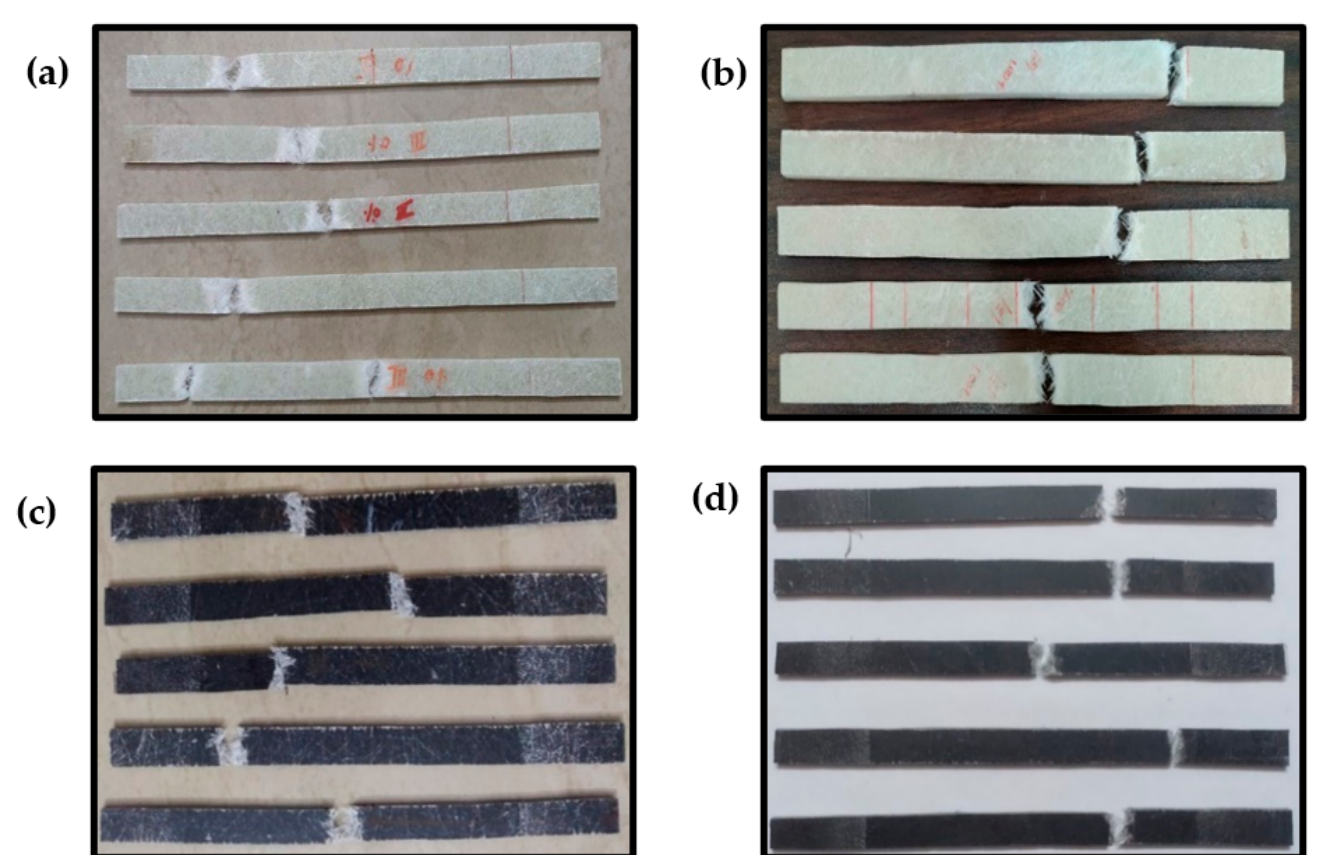
Figure 10. ( a ) Unfilled specimens; ( b ) uncarbonised eggshell filled specimens; ( c ) carbonised eggshell filled specimens; ( d ) hybrid specimens.